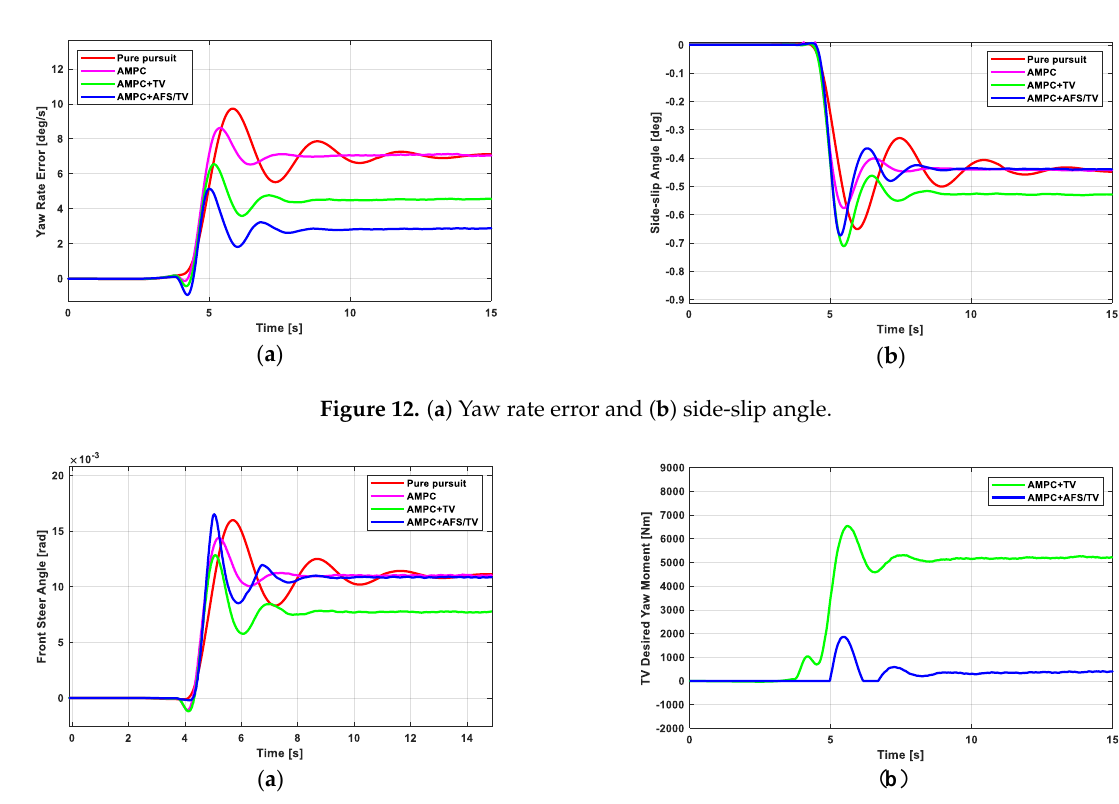
Figure 13. ( a ) Front steering angle and ( b ) desired yaw moment by TV.